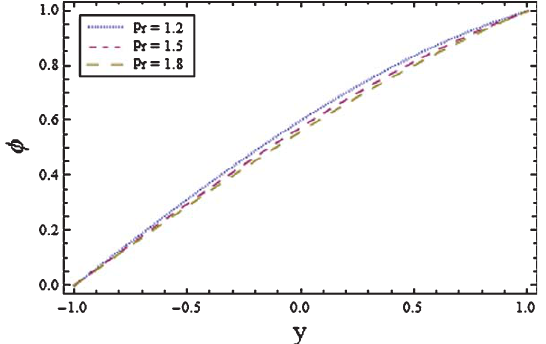
Fig. 14. Plot of concentration φ for various values of the Chemical reaction parameter γ with (cid:15) = 0 . 1, x = 0 . 1, t = 0 . 1 , Sr = 2 , Sc = 2 , Pr = 1 . 2 and Du = 2 .